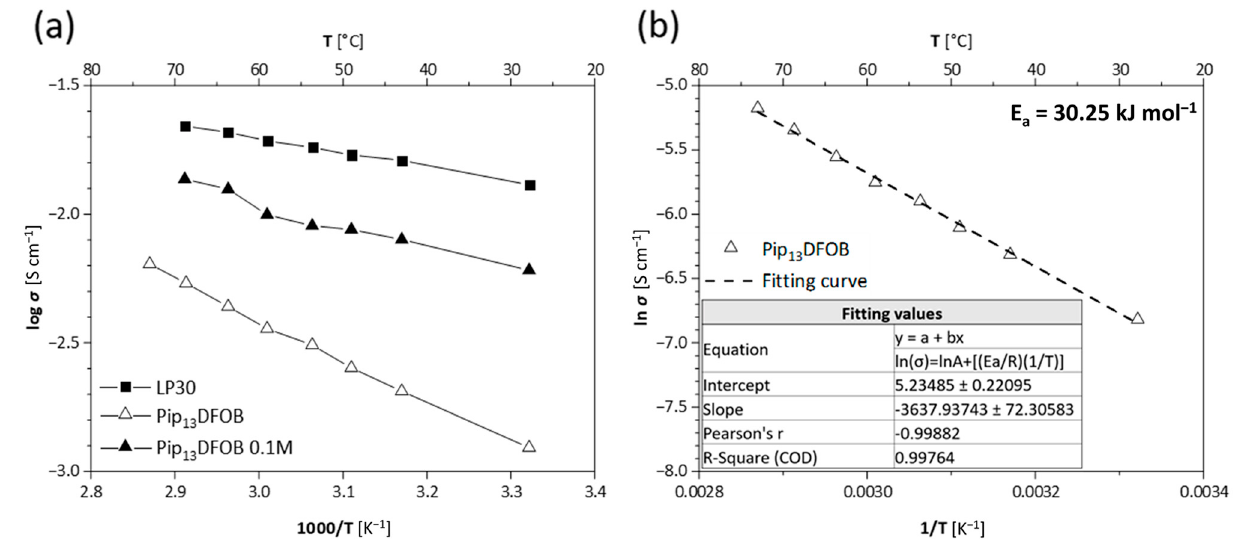
Figure 4. Ionic conductivity trend vs. temperature for Pip 13 DFOB, LP30, and 0.1 M Pip 13 DFOB solution ( a ), and a fitting result of conductivity of Pip 13 DFOB according to Arrhenius equation ( b ).